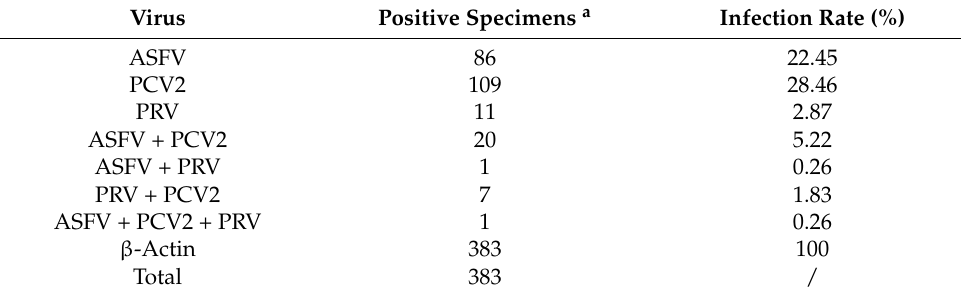
Table 5. Detection of field specimens by multiplex real-time